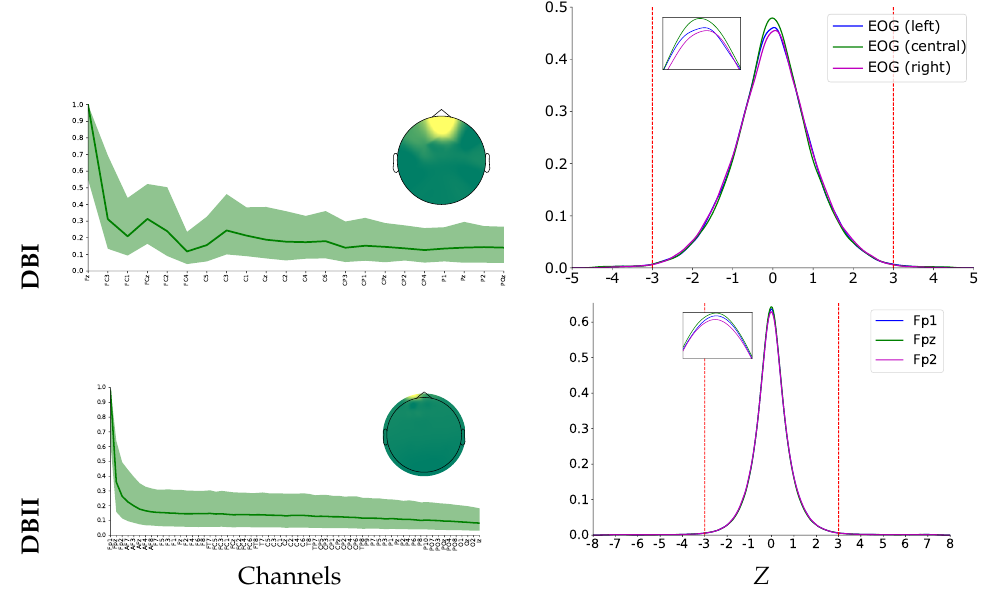
Figure 2. Effect of ICA filtering for EOG removal on both evaluated databases: DBI ( Top row ) and DBII ( bottom row ). Left column: the estimated electrode weights (normalized values are shown) and topograms. Right column: 3 sigma -level threshold of similarity used for EOG